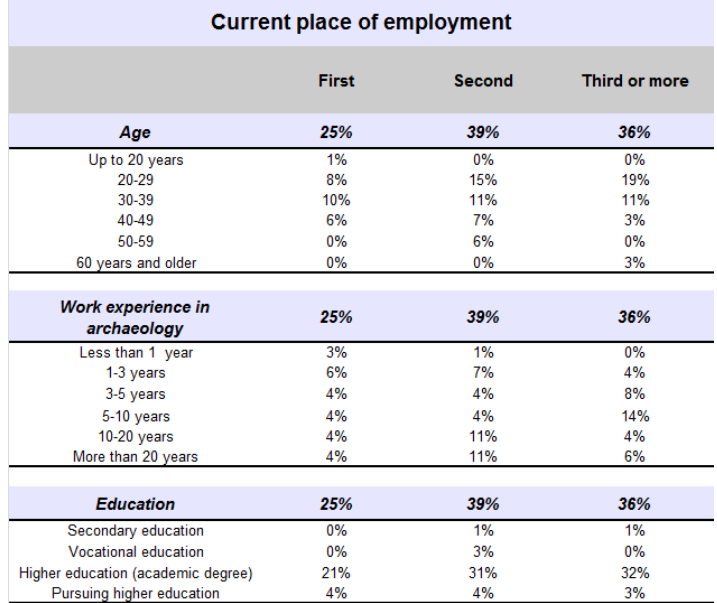
Table 22 - The current place of employment and employee characteristics